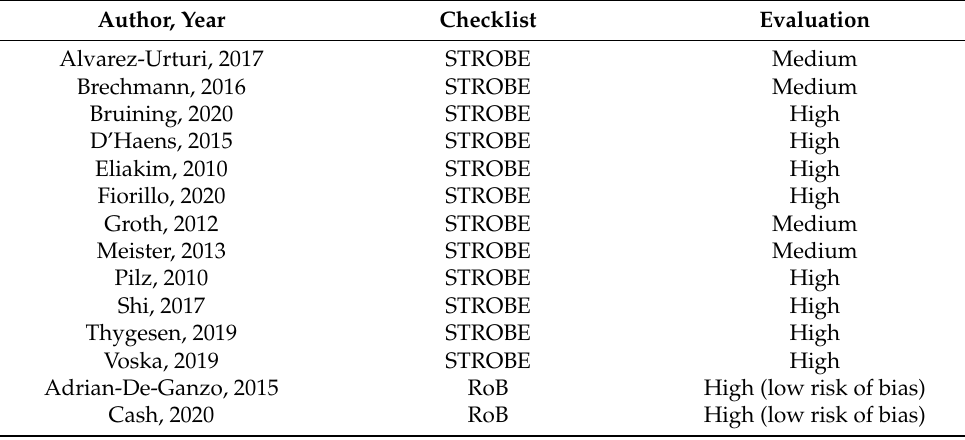
Table A2. Study evaluation of transparency and